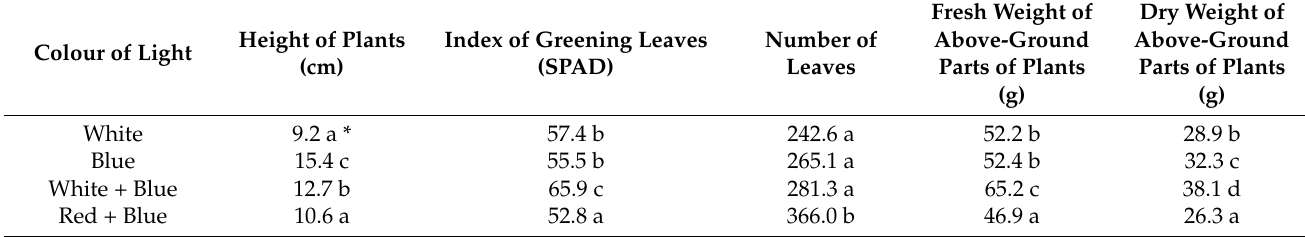
Dry Weight of Fresh Weight of Above-Ground Above-Ground Number of Parts of Plants Parts of Plants Leaves (g) (g)